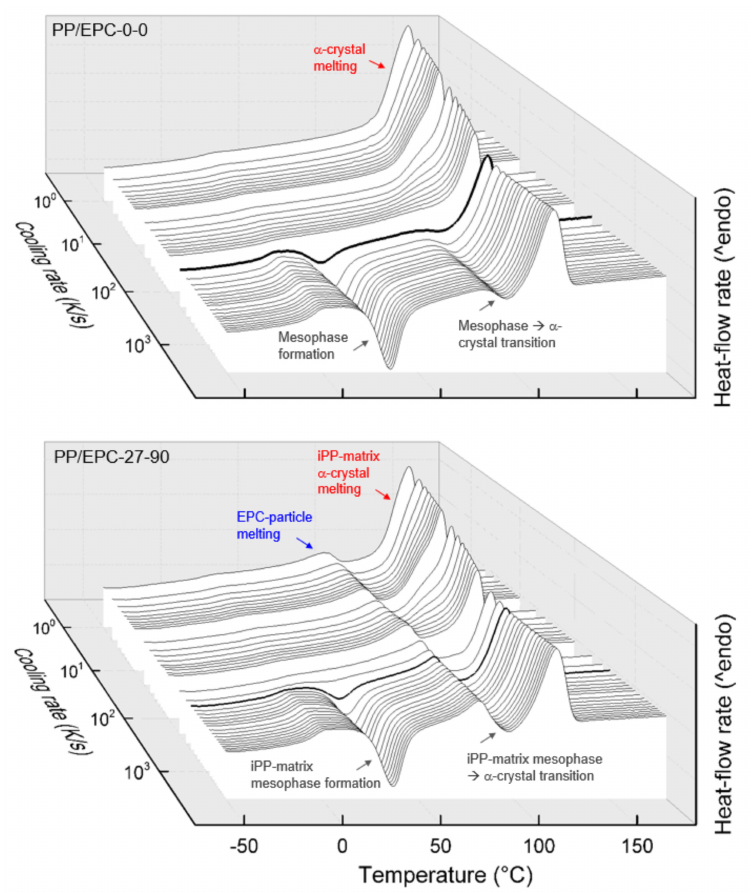
Figure 3. Sets of FSC heating curves of the samples PP / EPC-0-0 (iPP homopolymer, top) and PP / EPC-27-90 (heterophasic iPP, bottom). Exothermic heat-flow rate is directed downwards and the heating rate is 1000 K / s. Color coding of the various phase transitions is in analogy to Figures 1 and 2. Bold curves in the top and bottom plots refer to prior cooling at rates of 200 and 400 K / s,